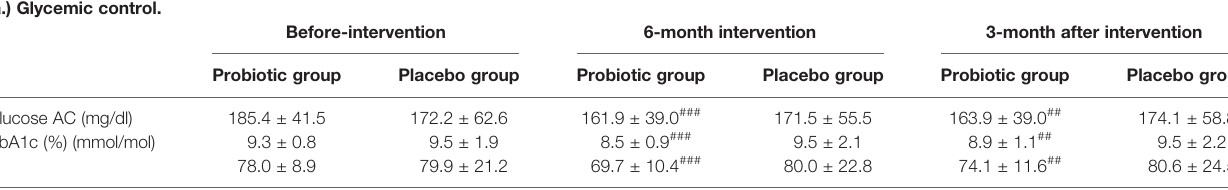
TABLE 2 | Glucose AC and HbA1c declined 6 months after consuming probiotic product.